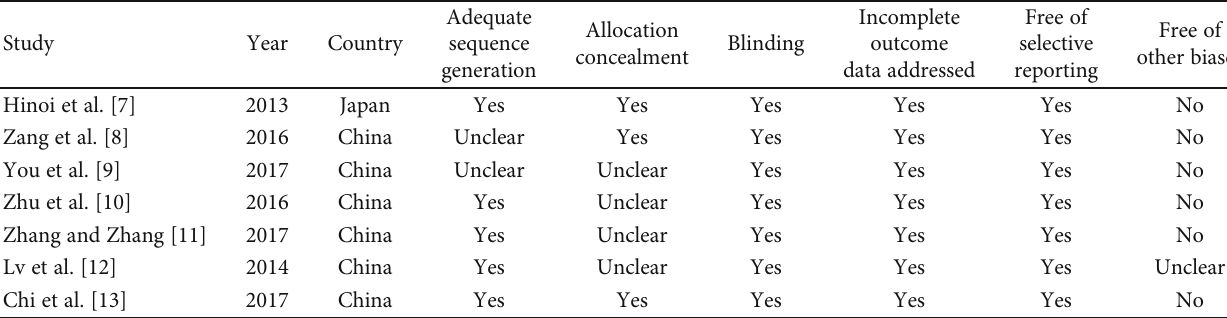
Figure 1: Flow diagram of studies identi fi ed, included, and excluded. Table 1: Characteristics of included